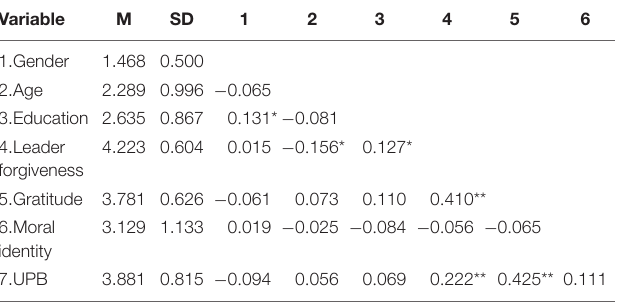
TABLE 3 | Means, standard deviations, and intercorrelations for study variables.